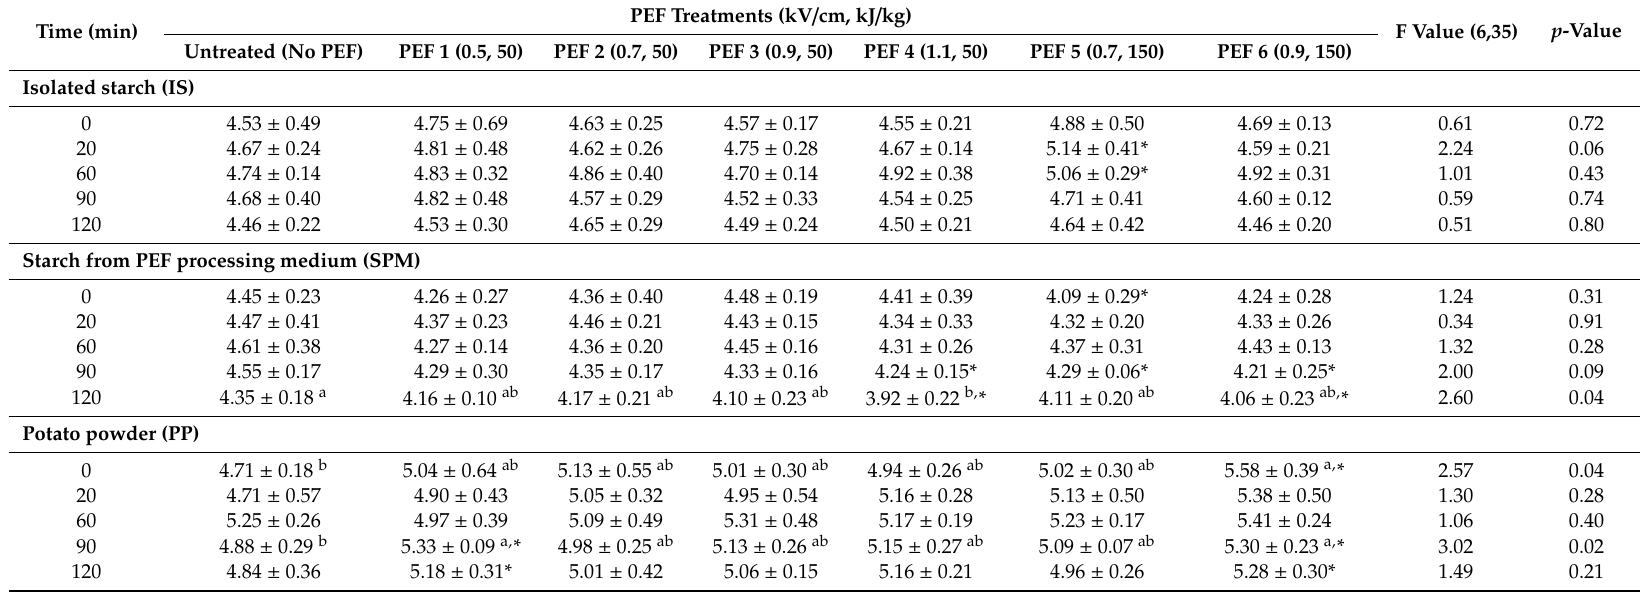
Table 4. Digestibility, expressed as milligram amount of glucose released per mL digest, of isolated starch (IS), starch from PEF processing medium (SPM), and potato powder (PP) from PEF-treated